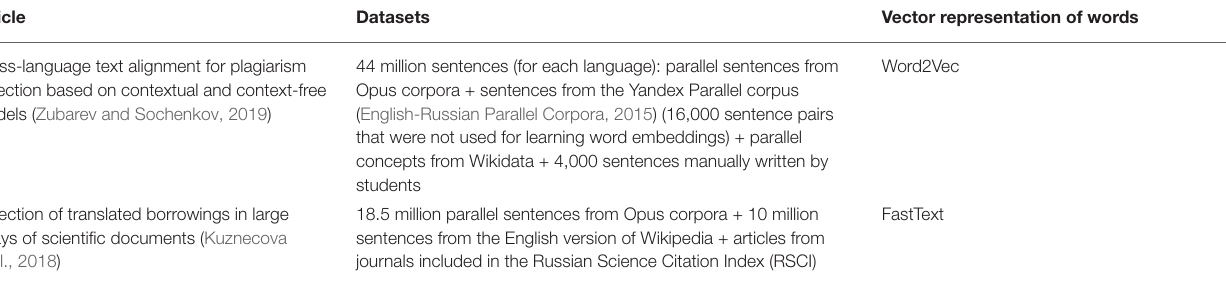
TABLE 5 | Comparative table for the used